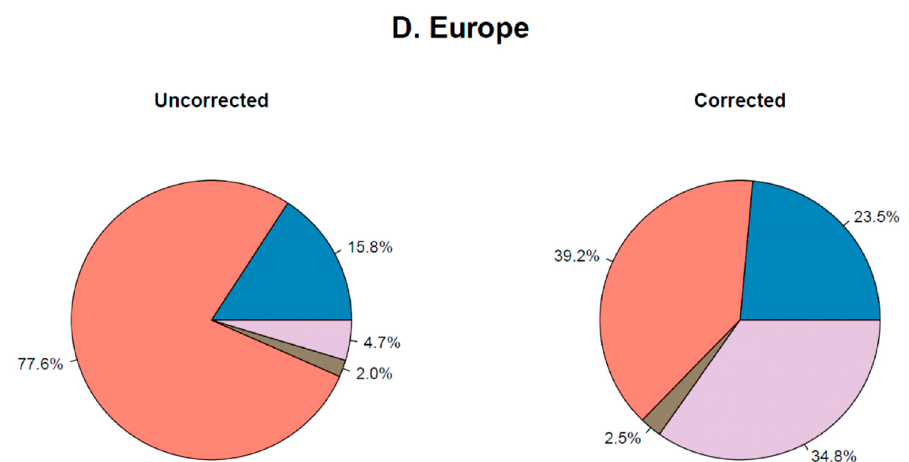
Figure 4. Pie charts displaying the species distribution reported in ( A ) all studies describing EV type distribution and in studies conducted in ( B ) Africa, ( C ) Asia and ( D ) Europe. Uncorrected pies display the distribution as reported by the studies. Corrected pie charts display the distribution corrected for the number of types in the species (20 in Enterovirus A , 59 in Enterovirus B , 23 in Enterovirus C and 4 in Enterovirus D).